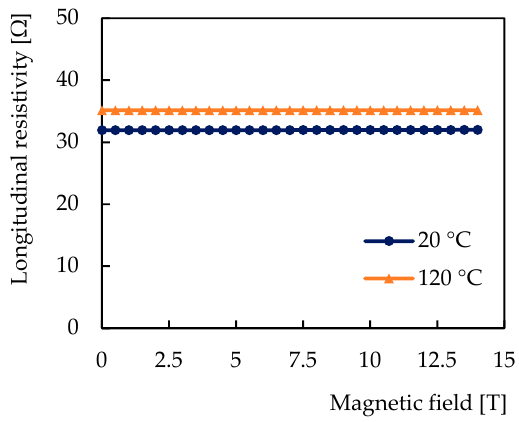
Figure 7. Hall coefficient of chromium of the sensitive nanolayer: ( a ) Dependence on the magnetic field at 20 °C and at 120 °C; ( b ) Dependence on the temperature in the magnetic field of 200 mT.